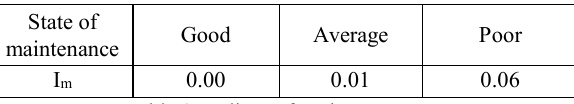
Table 3. Indices of Maintenance I m .